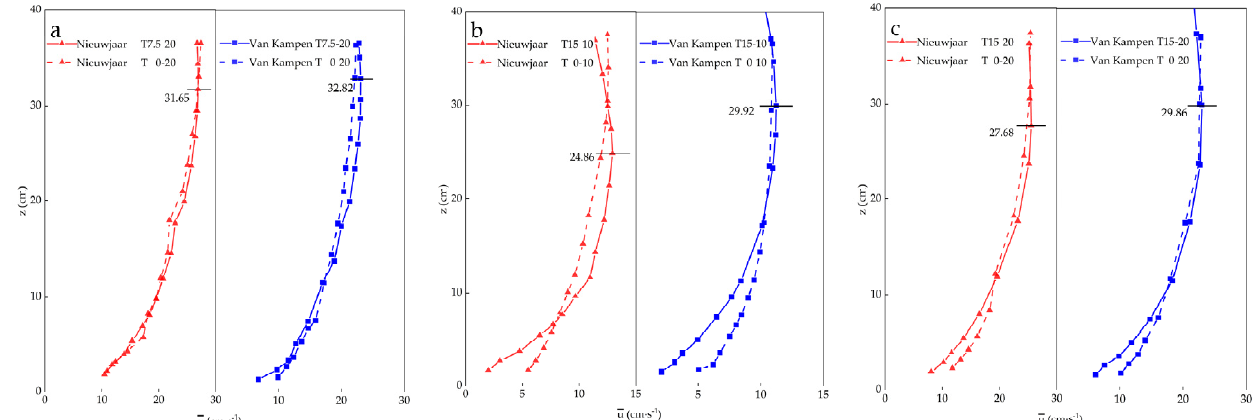
Figure 8. Laboratory measurements of u in two similar wave-current conditions in ripples of different sizes. ϕ cw = 0 ◦ in all the experiments. For example, T7.5-20 represents a lab experiment with a wave height of approximately 7.5 cm, a current velocity of approximately 20 cm/s. The short horizontal lines represent z d . ( a ) η = 1.5 cm and λ = 9.9 cm in van der Kaaij and Nieuwjaar [44], and η = 1.27 cm and λ = 8.44 cm in Van Kampen [45]; ( b ) η = 1.8 cm and λ = 10 cm in van der Kaaij and Nieuwjaar, and η = 0.86 cm and λ = 6.47 cm in Van Kampen; ( c ) η = 1.6 cm and λ = 11.1 cm in van der Kaaij and Nieuwjaar, and η = 1.1 cm and λ = 7.79 cm in Van Kampen.